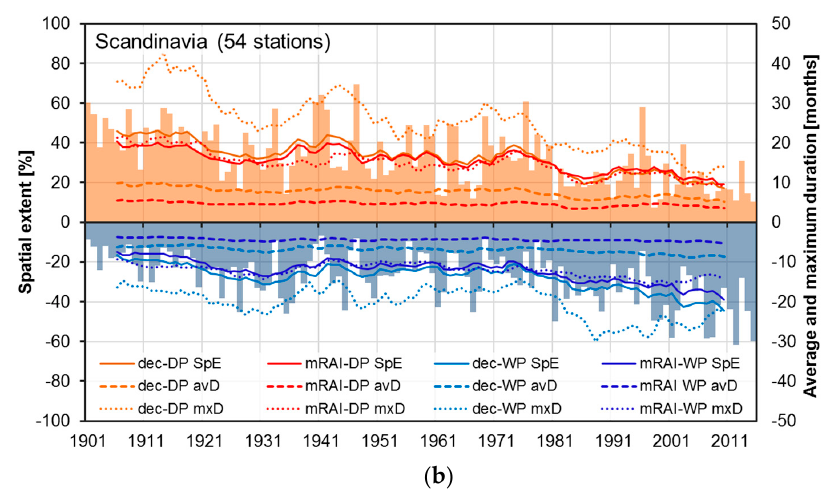
Figure A3. Time series (annual resolution; 11-year low pass filtered data) of spatial extent (SpE; bars for decile index) as well as average (avD) and maximum duration (mxD) of dry (DP) and wet periods (WP) as indicated by the deciles index (dec; orange and light blue) and the mRAI (red and intense blue) for the sub-regions ( a ) BI and ( b ) SC for period 1901–2015. For illustration purposes, the WP results are printed as negative values.